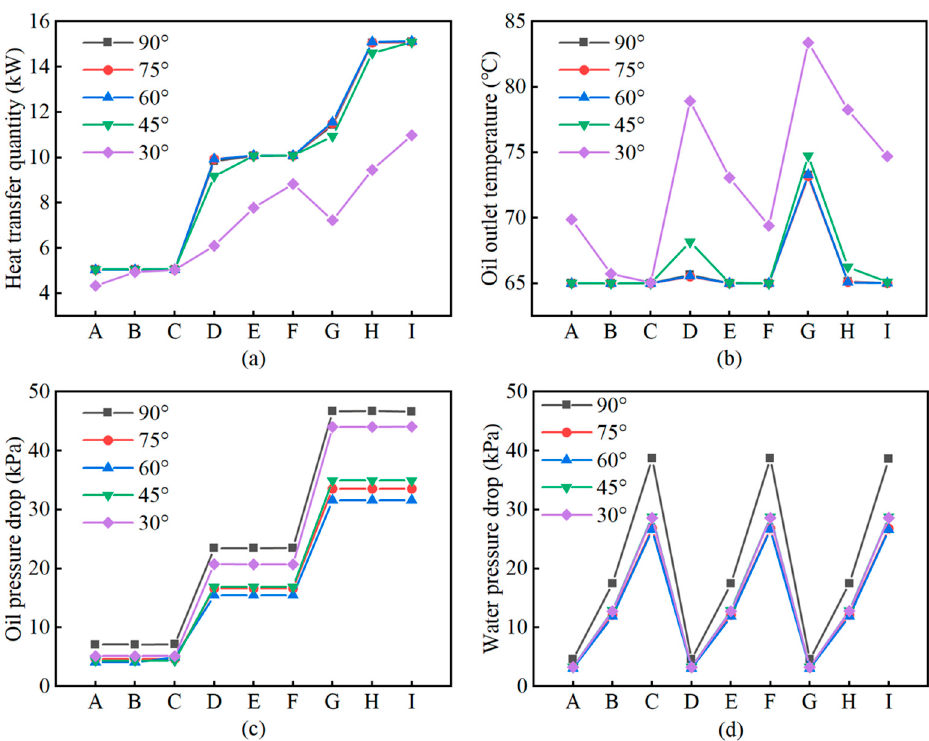
Figure 6. Simulation result, inlet flow on oil and water sides corresponding to simulation group numbers A to I is listed in Table 3: ( a ) heat transfer quantity of the heat exchangers, ( b ) oil outlet temperature, ( c ) oil pressure drop, ( d ) water pressure drop.